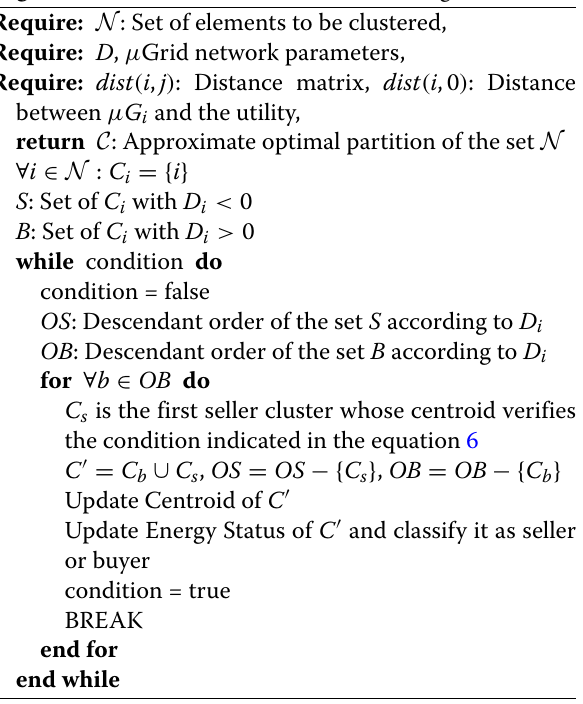
Algorithm 1 Hierarchical Leader Cluster